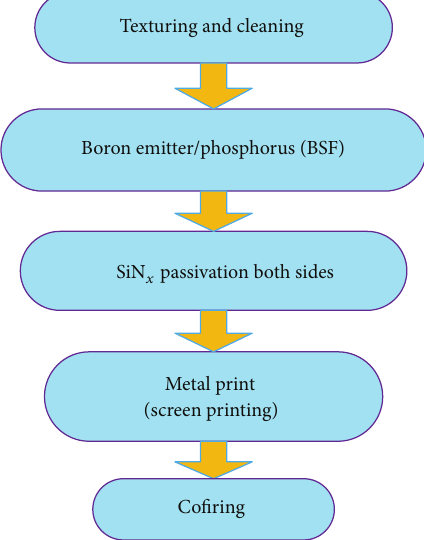
Figure 10: Flow chart of PANDA solar cell manufacturing